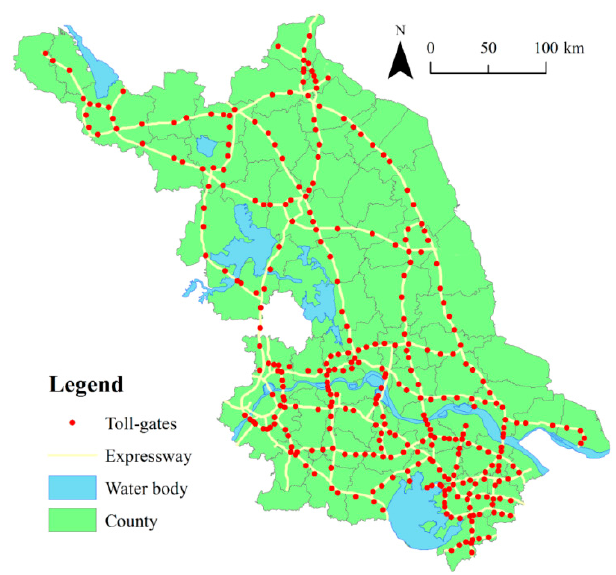
Figure 1. Distribution of 334 toll-gates and expressway network across the study area.